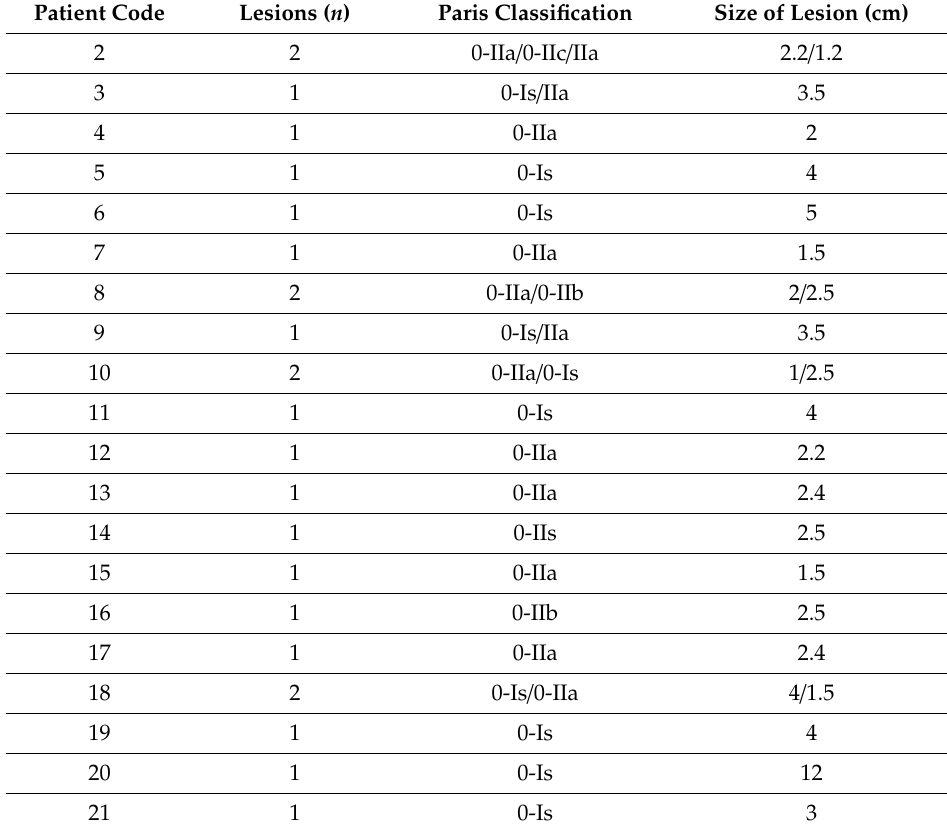
Table 2. Characteristics of